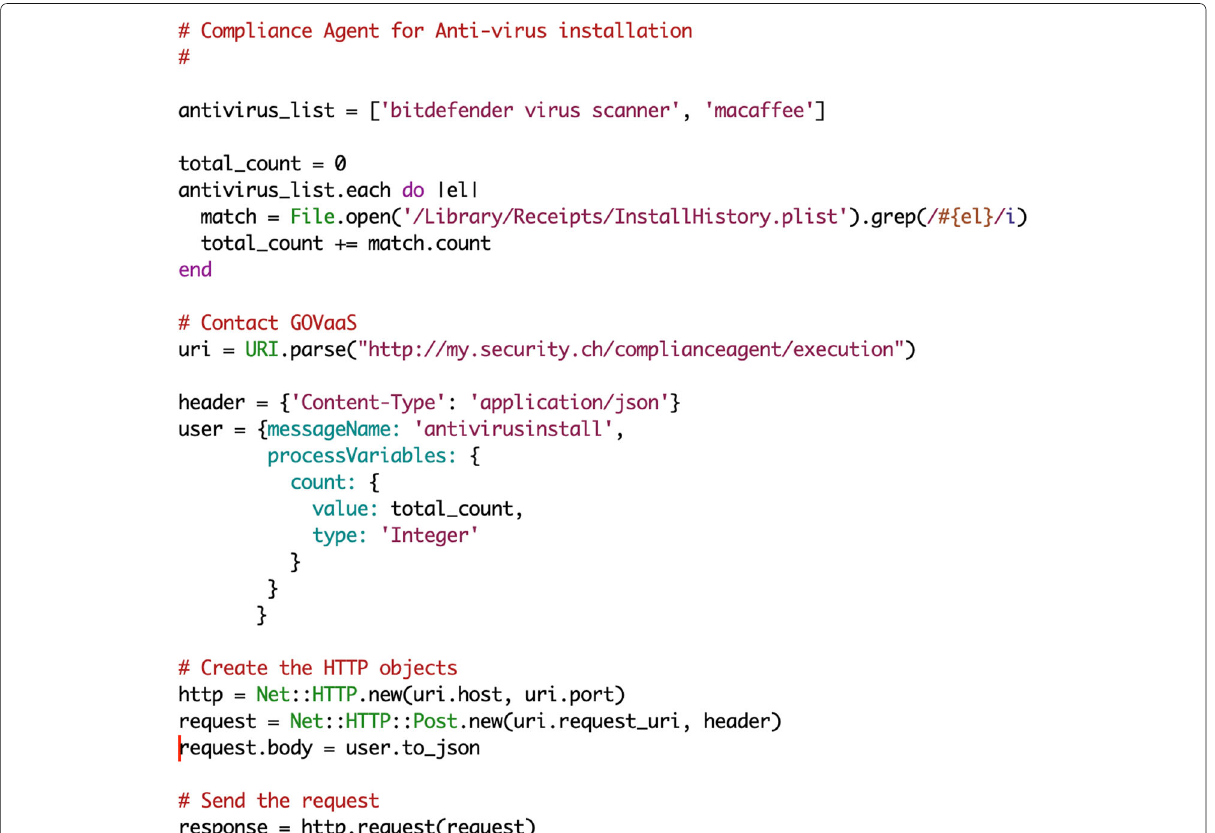
Fig. 16 Compliance agent for antivirus